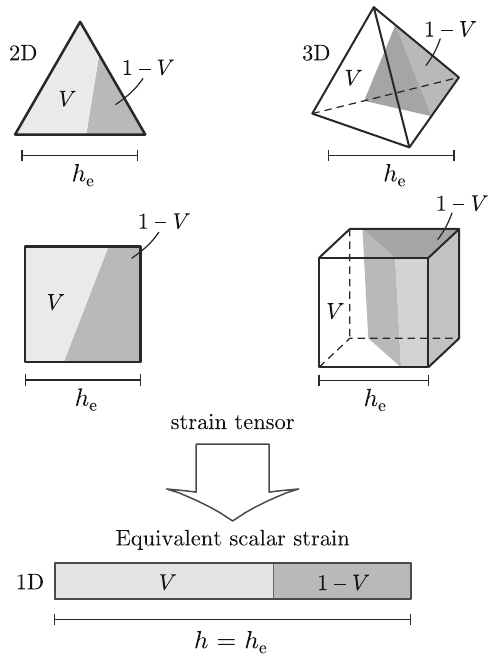
Fig. 4 Conversion of multi-dimensional problems into 1D